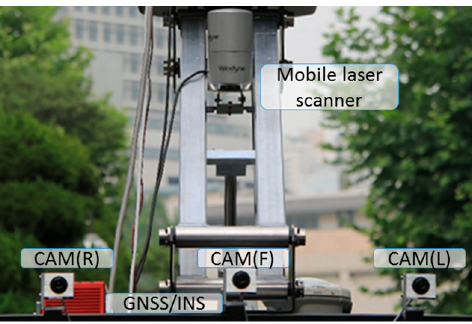
Figure 1. Configuration of mobile mapping system: network video cameras (F: front, L: left, R: right), mobile laser scanner, and GNSS/INS.